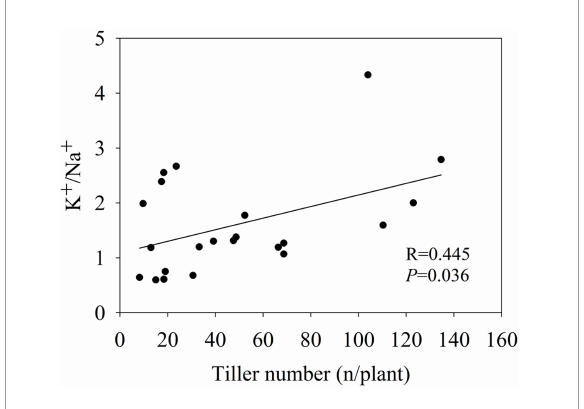
FIGURE7 The linear relationship between tiller number and K + /Na +